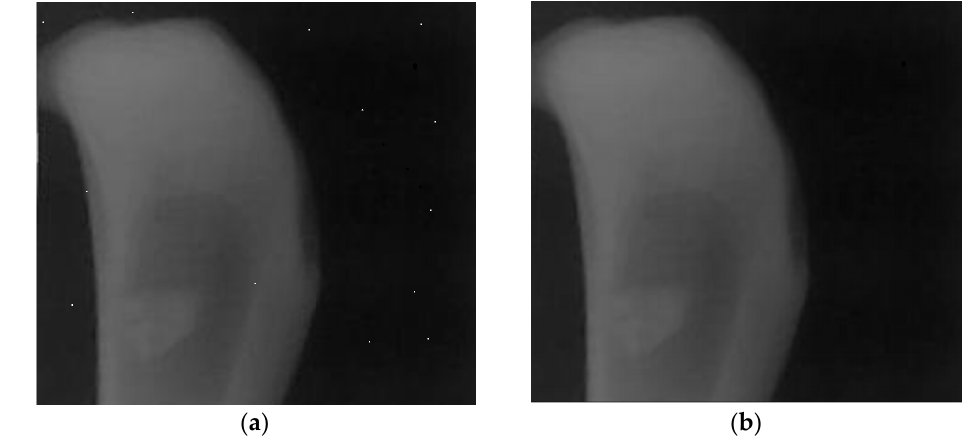
Figure 3. Salt and pepper noise reduction using a median filtering technique; ( a ) original s-X-ray detected image, ( b ) image result after taking the median filtering technique.